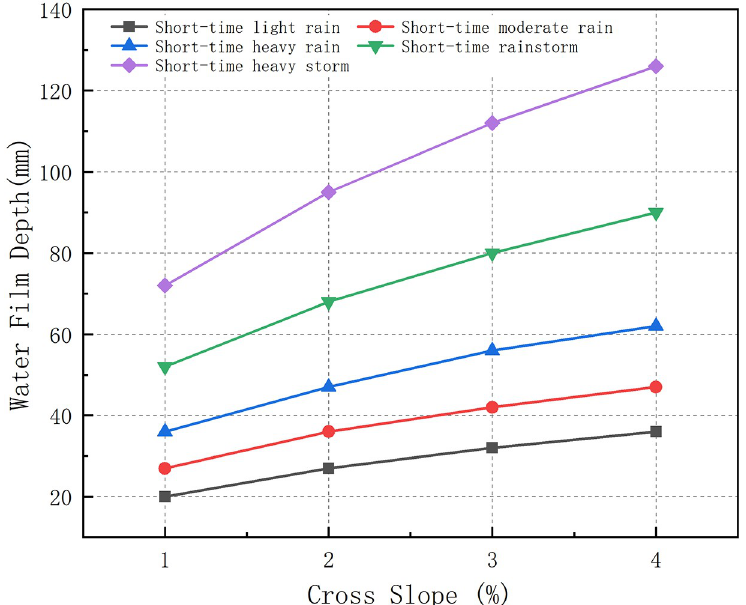
Fig 9. Cross slope dependence of the depth of water film (Model A).